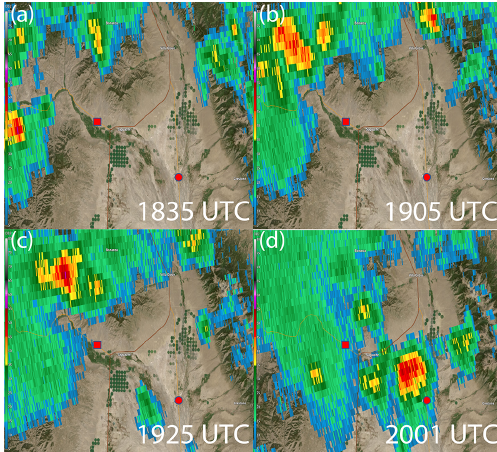
Figure 7. The 0.5 ◦ level reflectivity (dBZ) from the KPUX radar in Pueblo, CO, over San Luis Valley on 15 July 2018. The red square indicates the K04V site, and the red circle indicates MOFF. The times are as follows: (a) 18:35UTC (12:35MDT), (b) 19:05UTC (13:05MDT), (c) 19:25UTC (13:25MDT), and (d) 20:01UTC